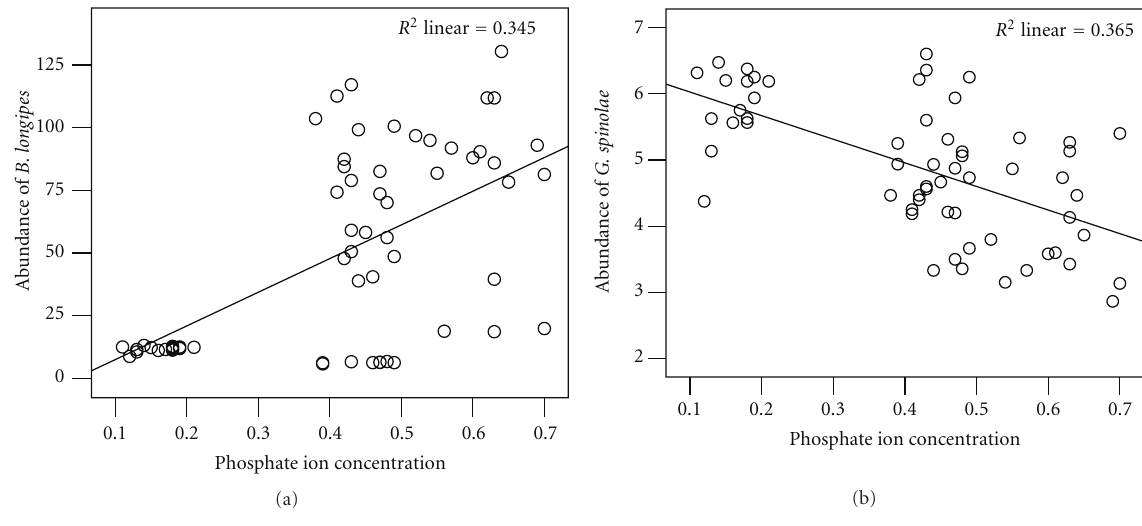
Figure 6: Relation between phosphate ion concentration and abundance of (a) Brachydeutera longipes (Hendel) and (b) Gerris spinolae (Lethierry and Severin) as shown by regression analysis.